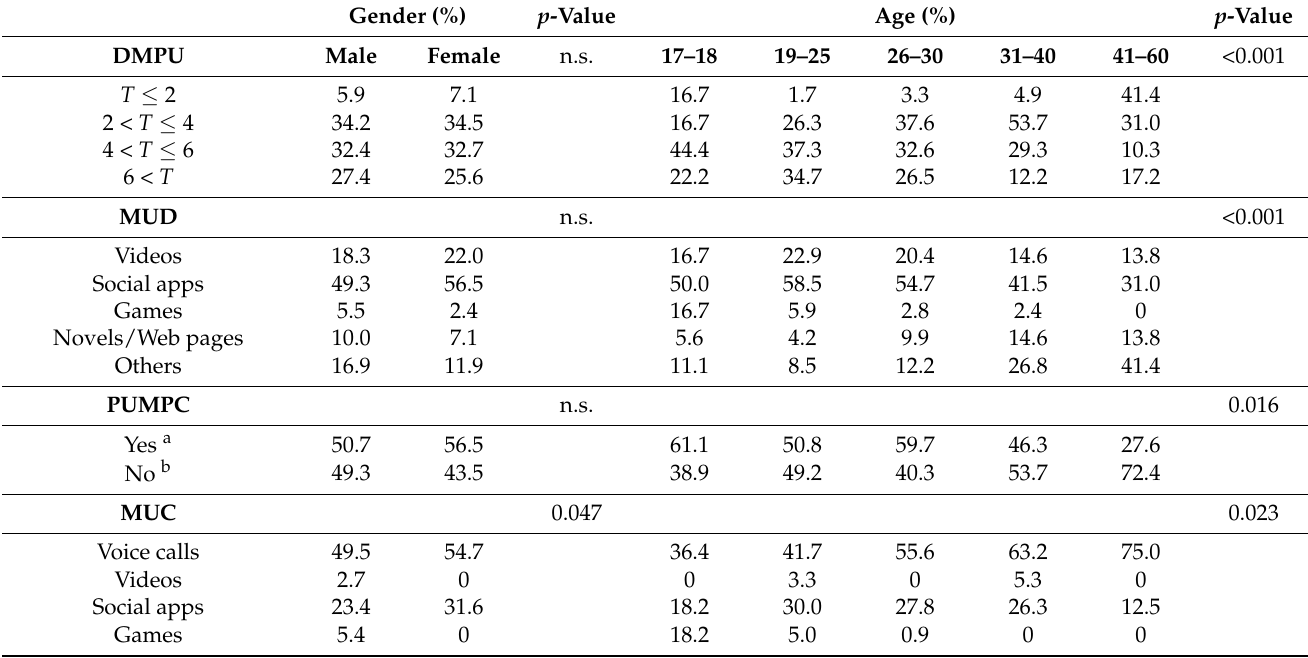
Table 2. Participant demographic characteristics and Chi-Square